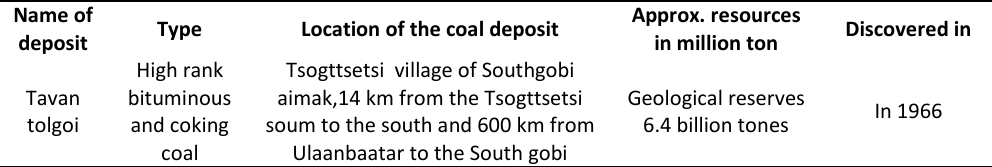
Table 1. Some informations about coal samples of Tavan tolgoi deposit